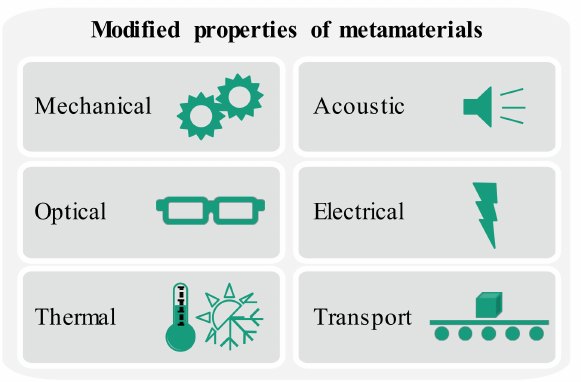
Figure1. Overviewofdi ff